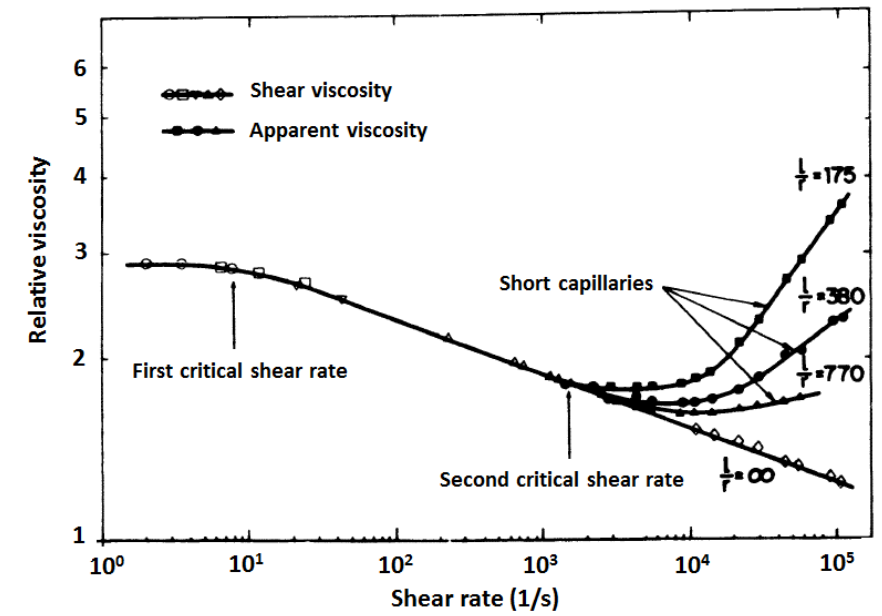
Figure 2. Comparison of shear and apparent viscosities in capillaries with different lengths. The experiments were performed at 30 °C with 0.034 wt% HPAM dissolved in a brine containing 2 wt% NaCl (1 wt% = 10,000 ppm). The radius (r) of the capillary was 1 mm and the length (l) varied. Adapted with permission from [82].